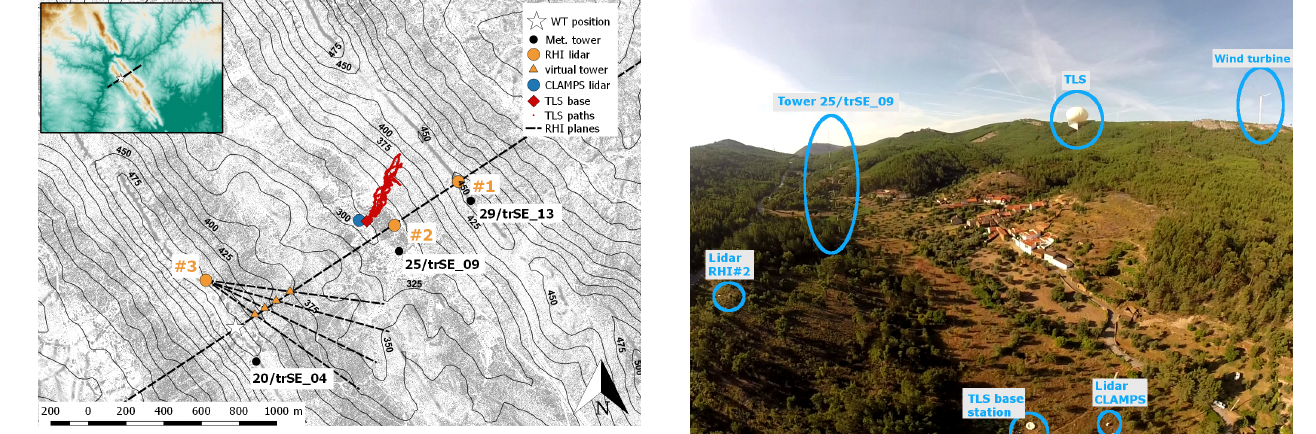
Figure 2. Aerial view over the measurement site from the